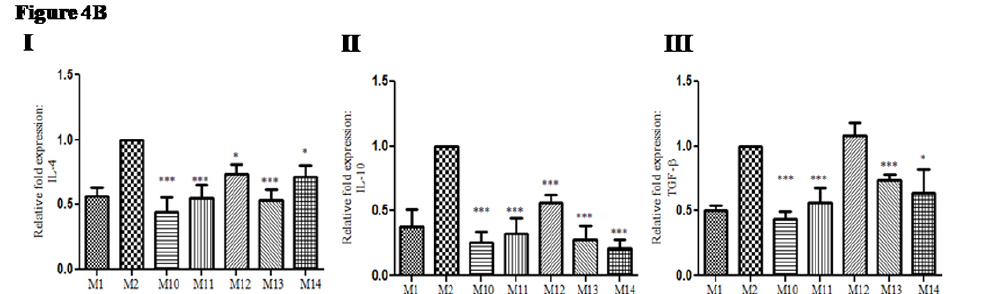
Fig. 4B. Change in anti-inflammatory gene expression in infected mice upon adjunct therapy of recombinant cytokines (IL-17A and IFN- γ ) along with sub-optimal dose of AmpB: (I) Gene expression of IL-4 (II) Gene expression of IL-10 (II) Gene expression of TGF- β